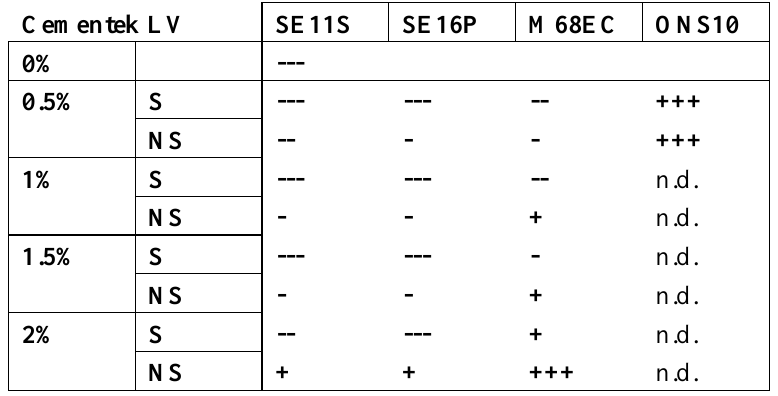
Table 5. Disintegration of Cementek LV in water, after injection through a syringe (―worm‖ shaped). With cement and surfactant sterilized together: ―S‖, or not sterilized together: